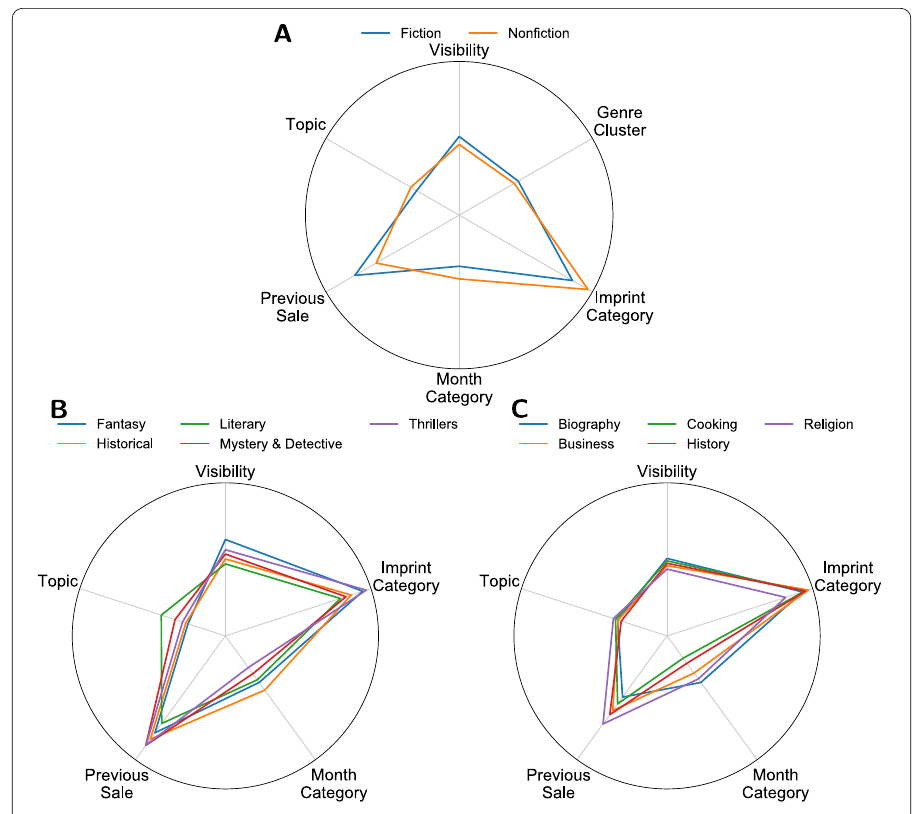
Figure 9 Feature group importance radar plot. ( A ) Radar plot of feature group importance for fiction and nonfiction books. Imprint is the most important feature group for both fiction and nonfiction. However,